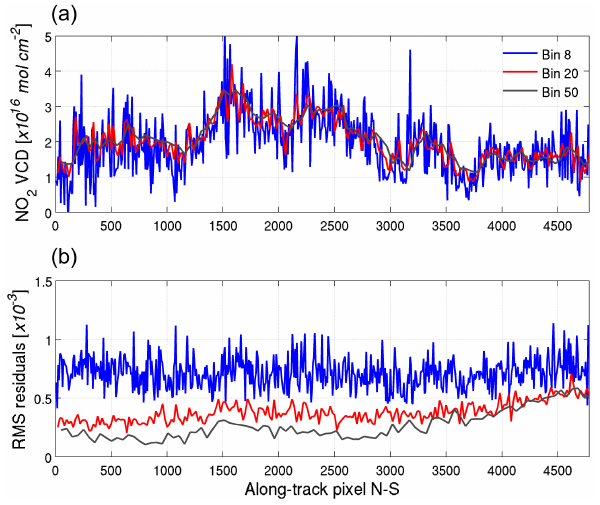
Figure 4. Along-track profile of (a) NO 2 VCDs and (b) rms error of DOAS fits for three different levels of aggregated spectra, i.e. 8 by 8, 20 by 20 and 50 by 50 pixels. The VCDs are retrieved from an overlapping column on flight line eight of the Antwerp data set and are plotted from north to south.